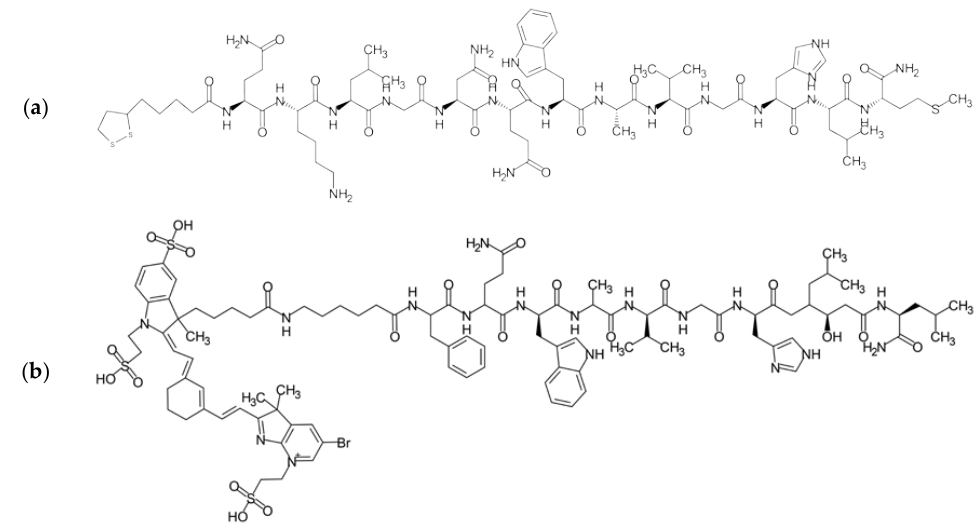
Figure 7. Structures of bombesin derivatives: ( a ) modified with thioctic acid for binding with gold nanoparticles [72]; ( b ) AF750-6Ahx-Sta-BBN for biding with nanographene oxide via hydrogen and π – π interactions [40]. Sketched with MarvinSketch 22.13 (ChemAxon Ltd., Budapest, Hungary).